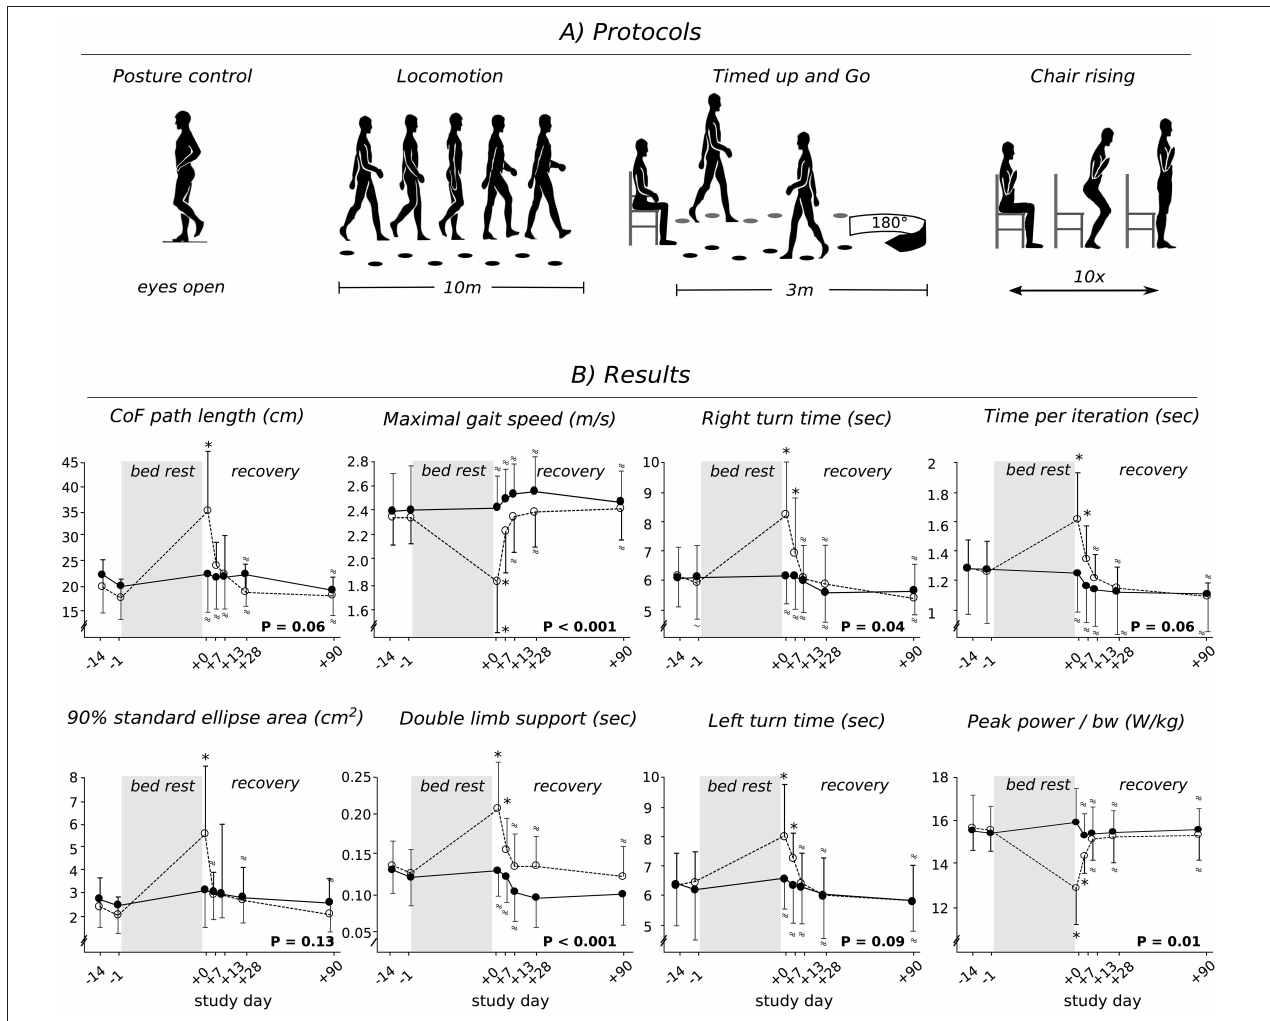
FIGURE 2 | Protocol schematic (A) and grand means (B) for the inactive CTRL (open circles) and the JUMP group (full circles). Data is displayed for baseline measurements (BDC-14 and BDC-1) and the recovery period (R + 0, R + 7, R + 13, R + 28, and R + 90) after the 60 days of bed-rest. Changes in center of force (CoF) path length and standard ellipse area in the balance test, gait speed and double limb support, time for the left and right turn for “Timed Up and Go” test, time and peak power chair-rising with respect to baseline (BDC-1). Values are means ± SE. P < 0.05 denotes a significant group*time interaction effect. * indicates a significant difference compared to baseline. If values were statistically non-inferior compared to baseline, they are marked with a ≈